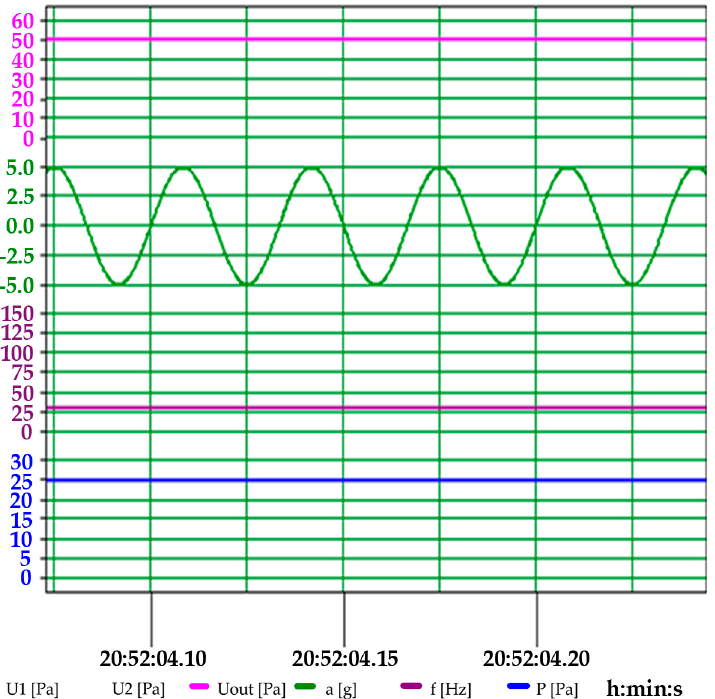
Figure 18. Waveforms of the experimental values of acceleration (a), pressure (p), and output signal (U out ) for dynamic acceleration with vibrations and with an amplitude of 5 g, frequency of f = 30 Hz, and pressure excitation of p = 25 Pa for the double-membrane transducer.